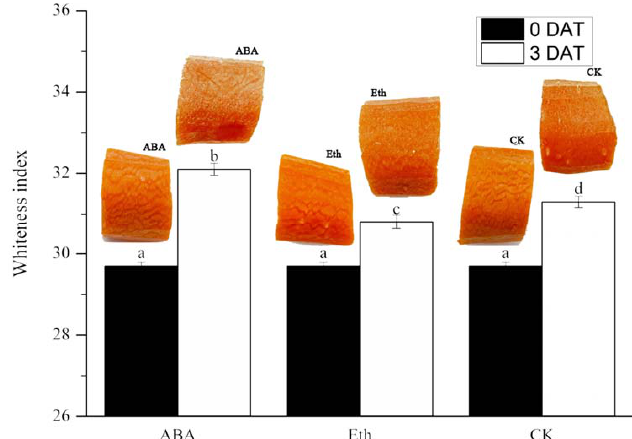
Figure 1. Whiteness index of each treatment group in fresh-cut carrot. DAT: days after treatment; ABA: the fresh-cut carrot was treated with abscisic acid; Eth: the fresh-cut carrot was treated with ethylene; and CK: the fresh-cut carrot was treated with cleaning water. Each value is presented as the mean ± SE (n = 3). Means with different letters are significantly ( p < 0.05) different between each sample type for different treatment groups.